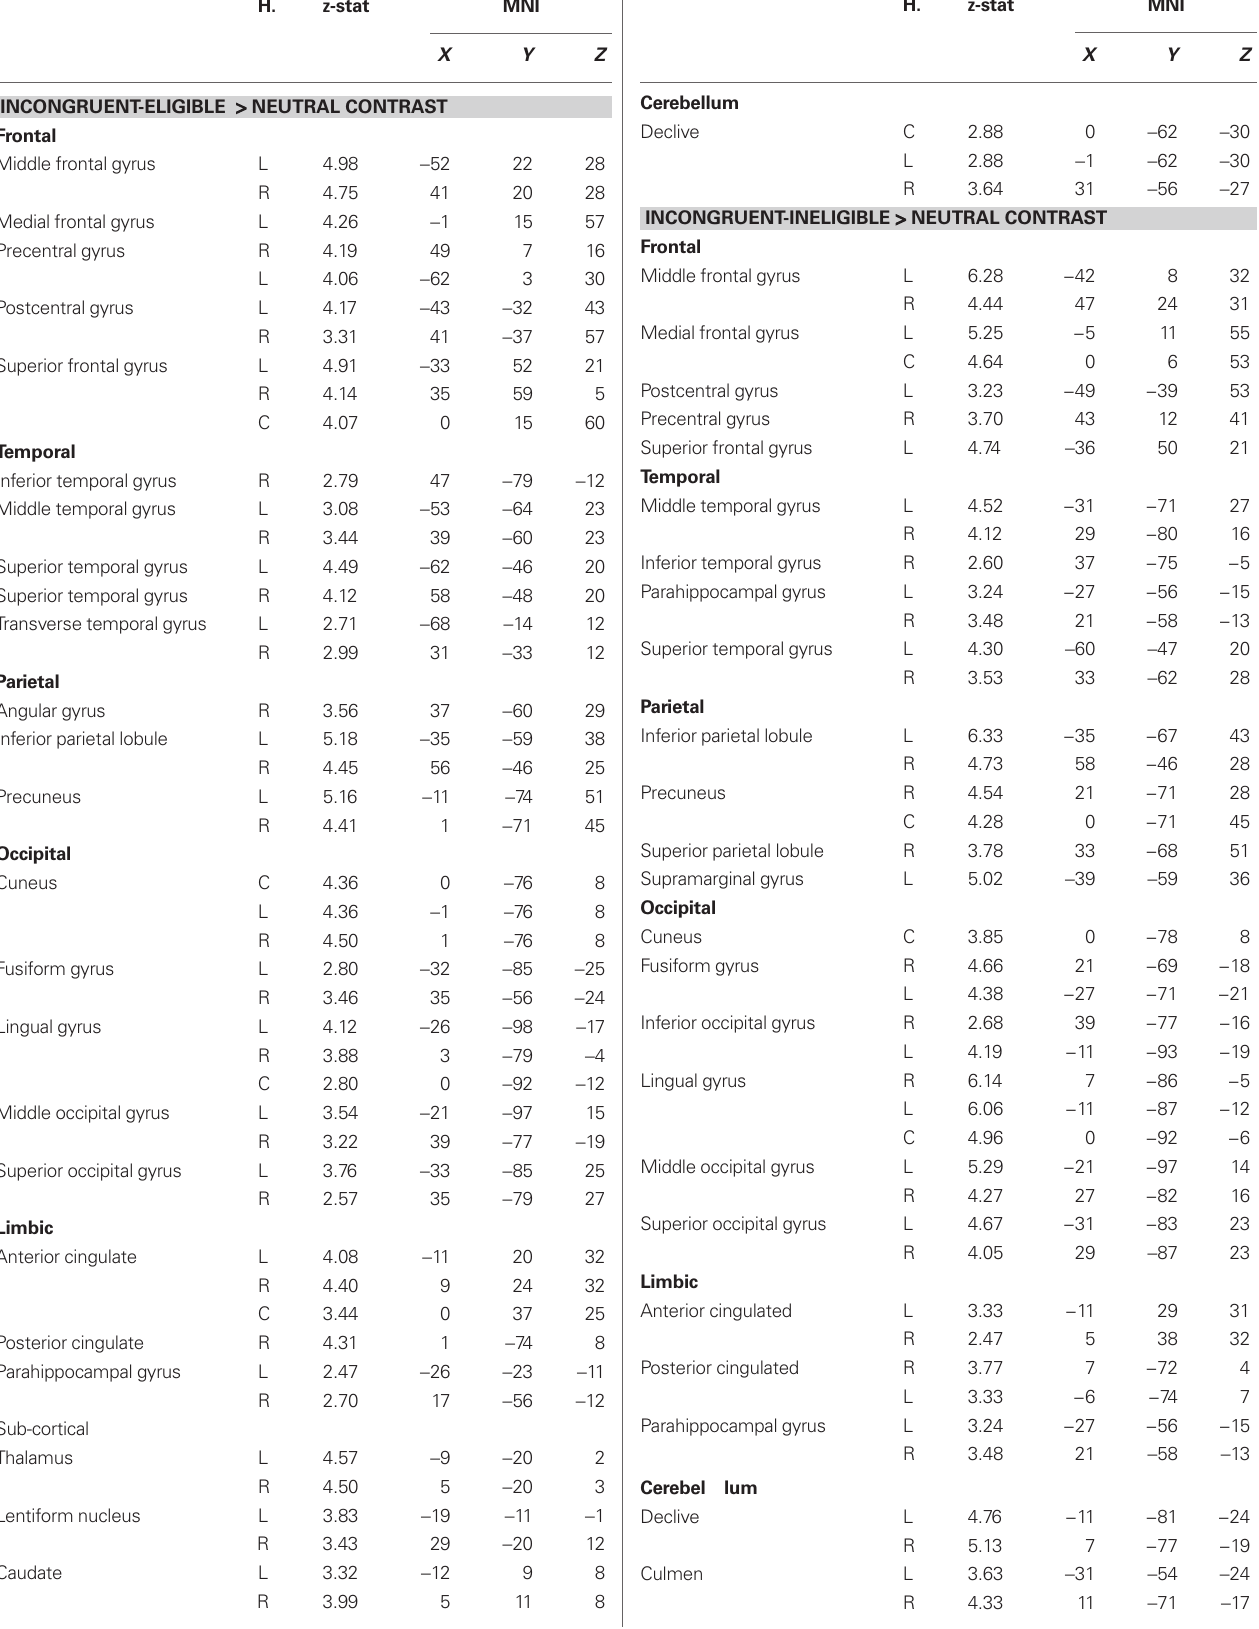
Table 2 | Cortical regions activated during the incongruent-eligible > neutral contrast and incongruent-ineligible > neutral